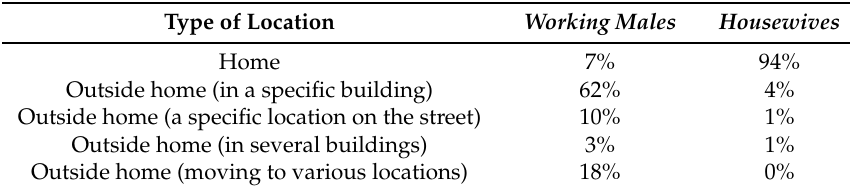
Table 5. Distribution of location for main activity.